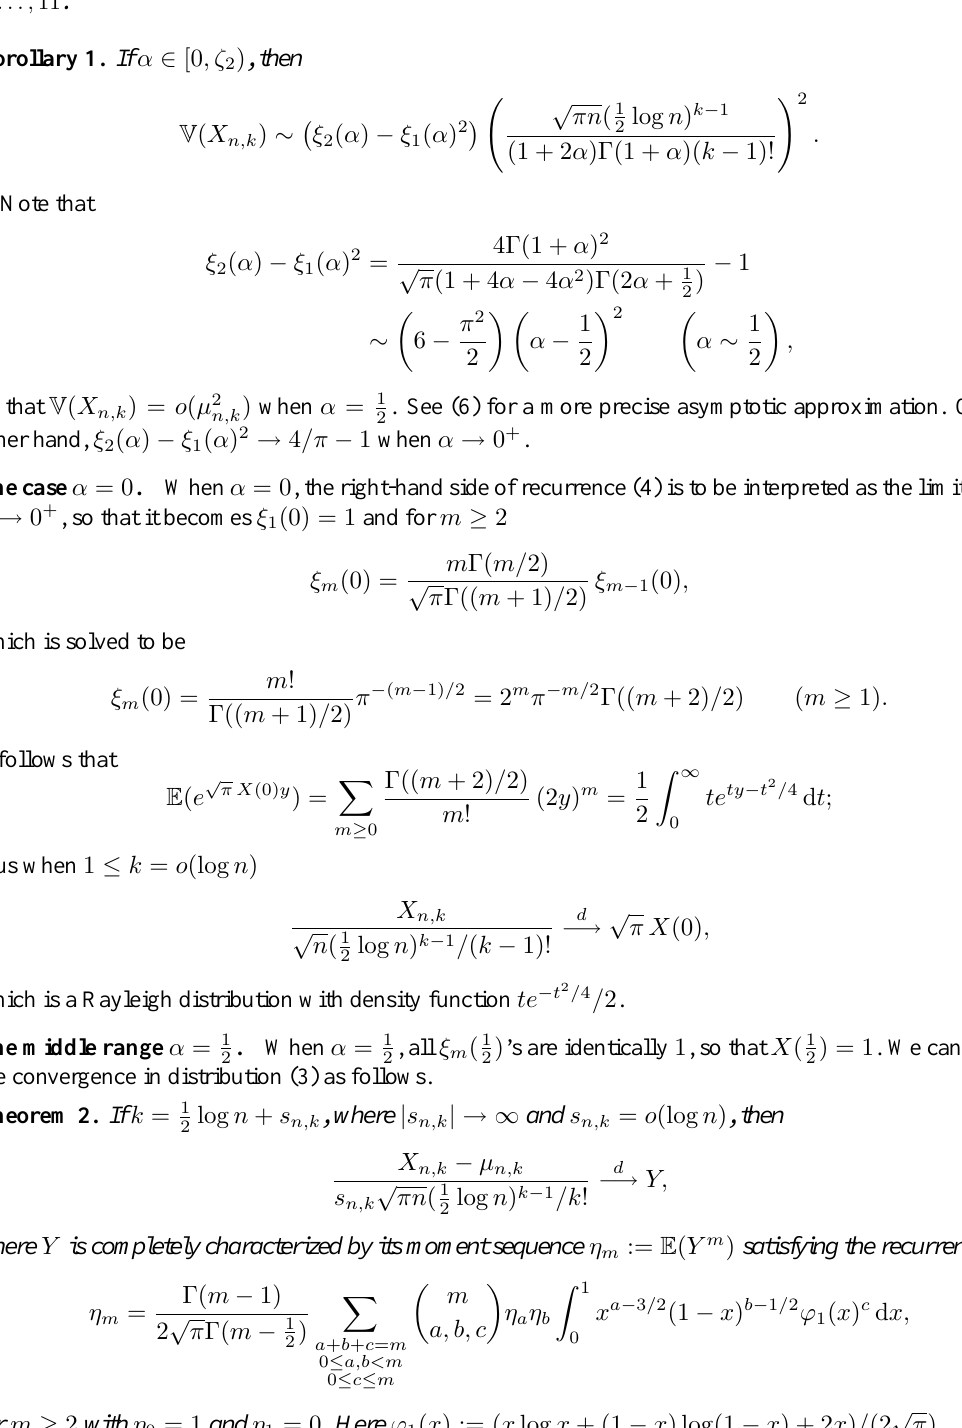
) − (2 z ) m = 1 , for m = 2